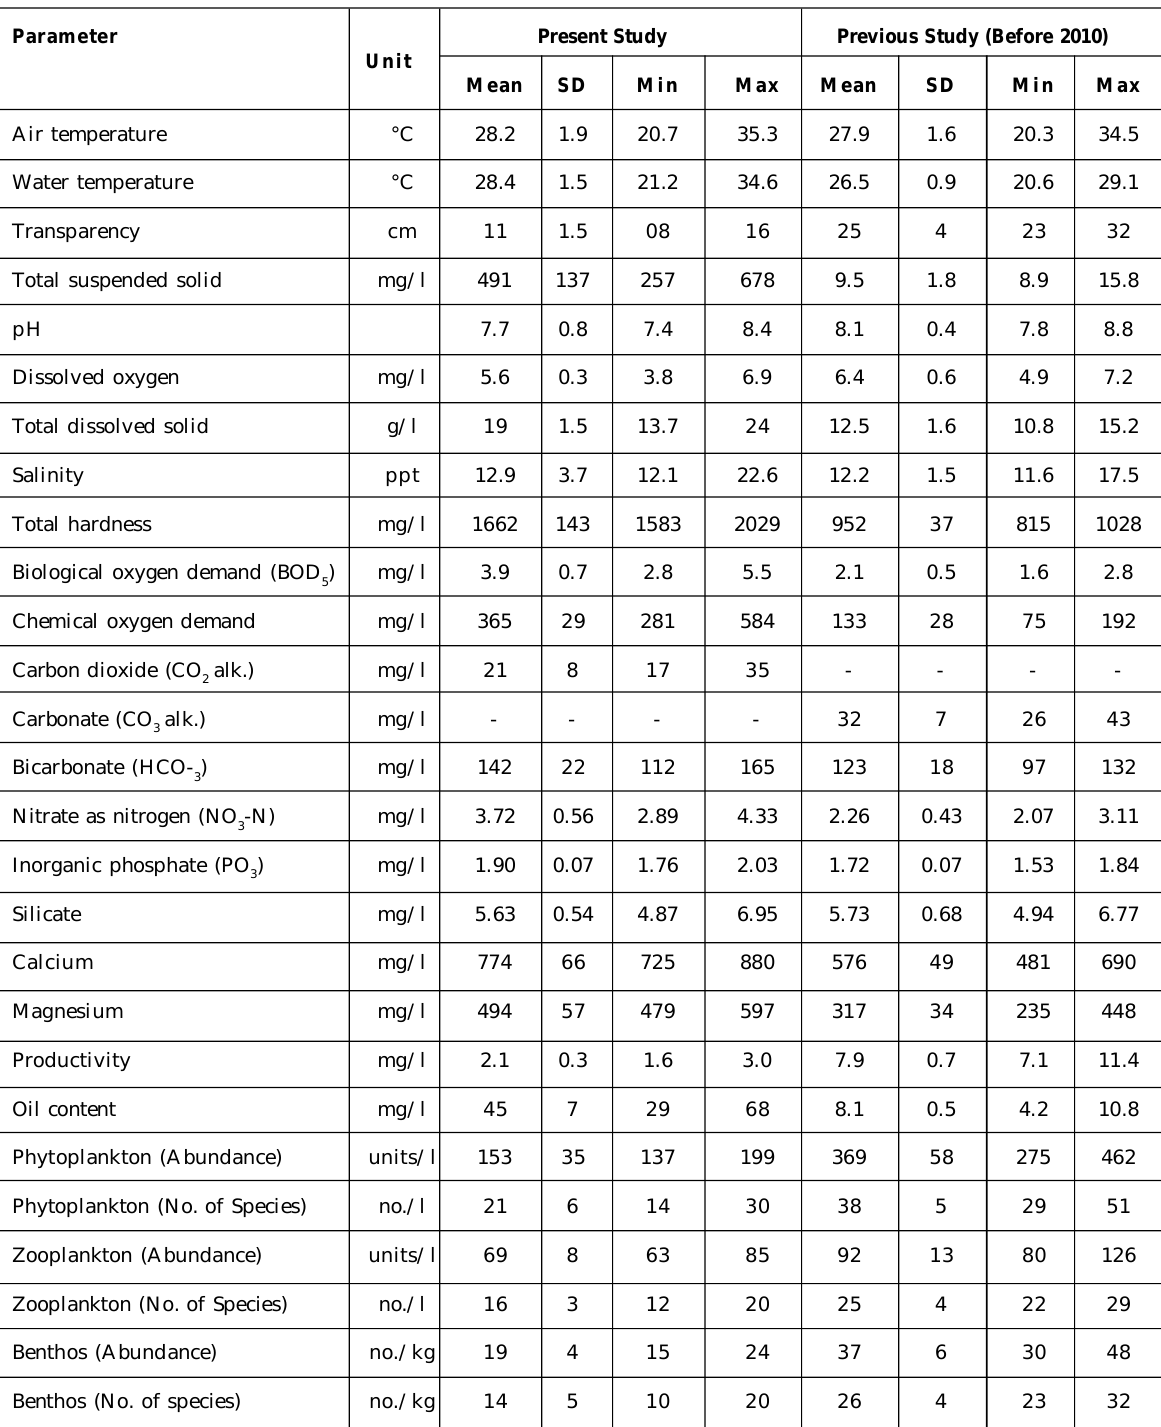
Table 1: Physico-chemical and biological conditions in the water bodies of the study areas (Rampal, Mongla and The Sundarbans) Parameter